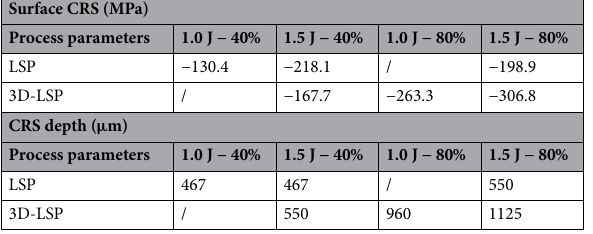
Table 2 details the surface CRS and respective CRS depth for each of the curves corresponding to the LSP process parameters. As expected from previous studies 11 , both increasing the laser energy and the overlap cor-